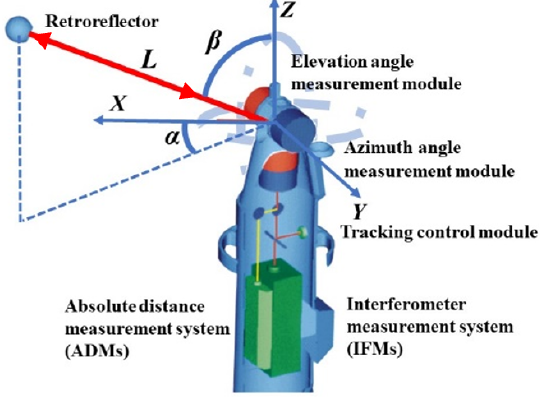
Figure 1. The typical coordinate system of a laser tracker.